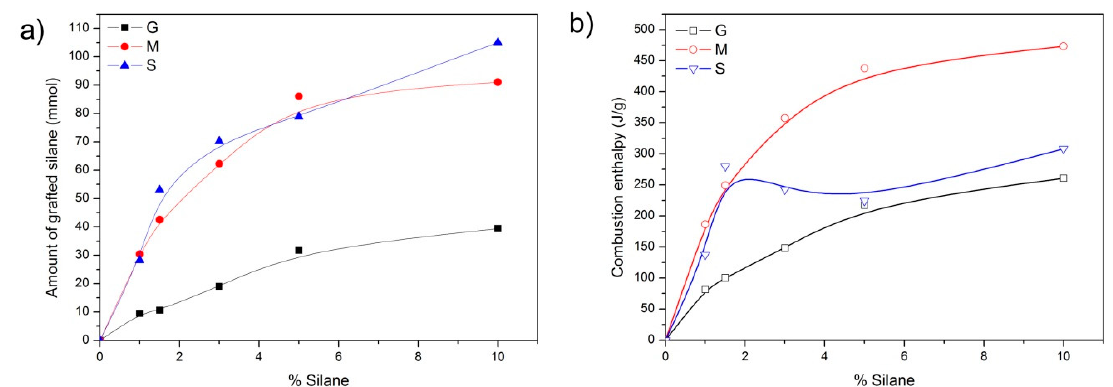
Figure 6. ( a ) Amount of coupling agent (in mmol) at each concentration of silane incorporated during the synthesis, and ( b ) combustion enthalpy of the silanes. Lines are plotted to guide the eye.